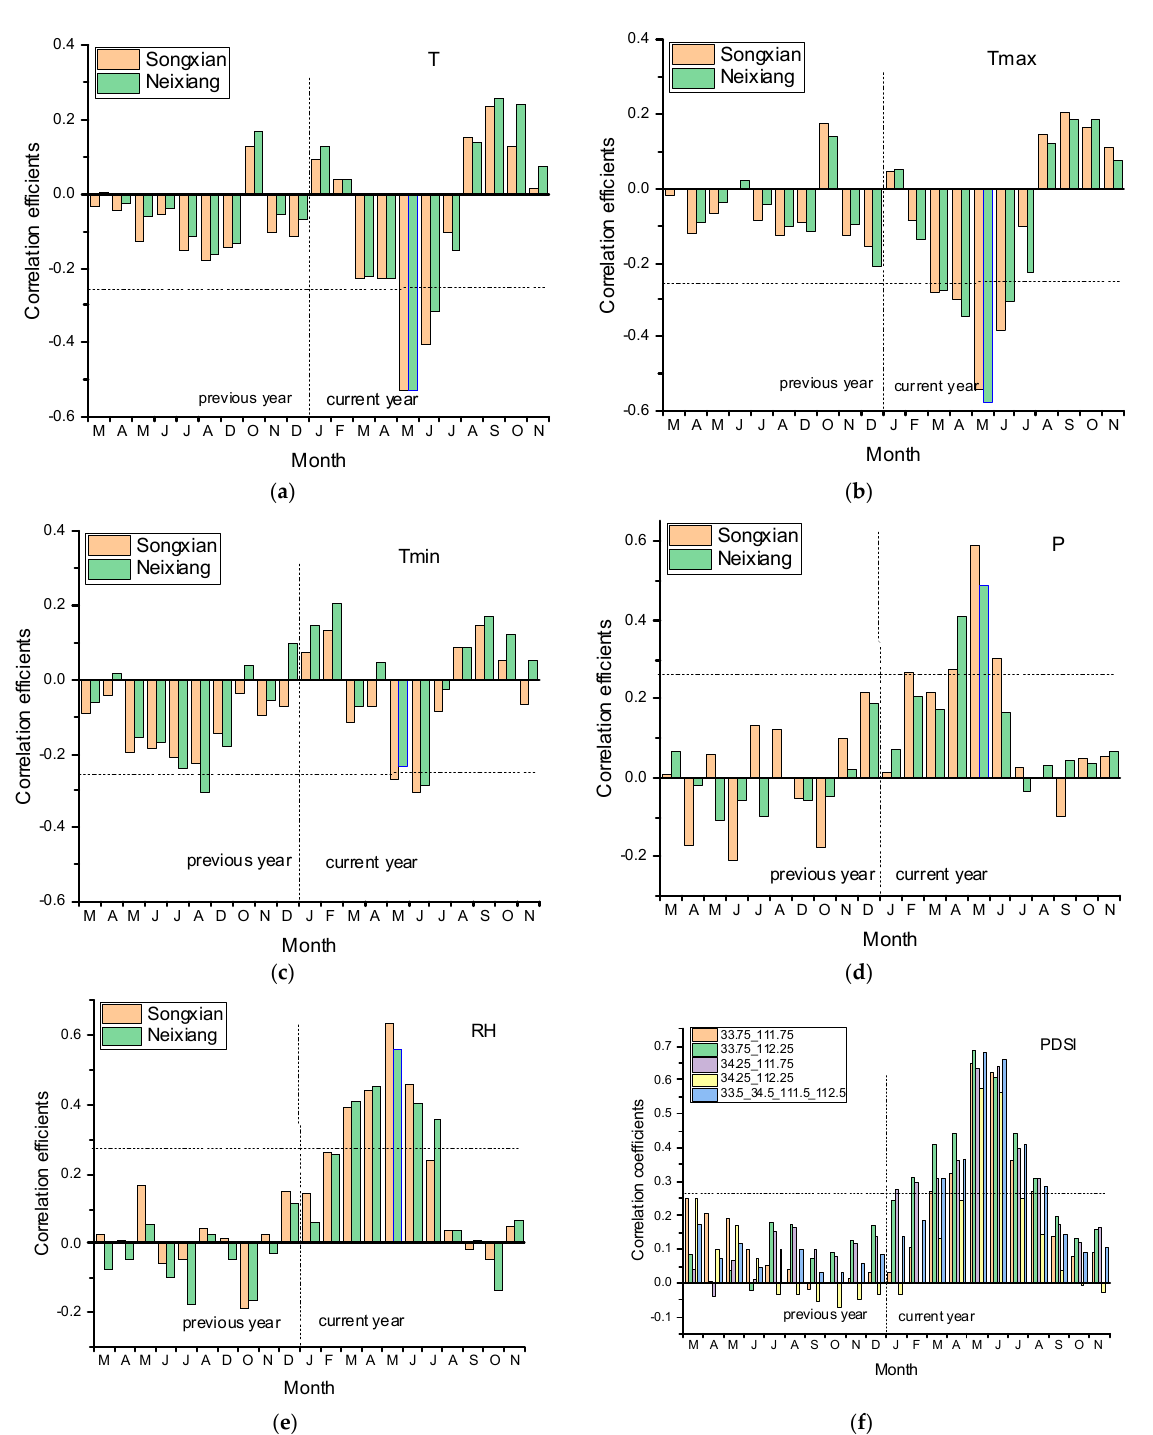
Figure 3. Correlation coefficients between the chronology and climatic factors (T(a), Tmax(b), Tmin(c), P(d), RH(e) and scPDSI(f)) in the Songxian (brown bar) and the Neixiang stations (green bar), respectively. The horizontal dashed line represents p < 0.05.